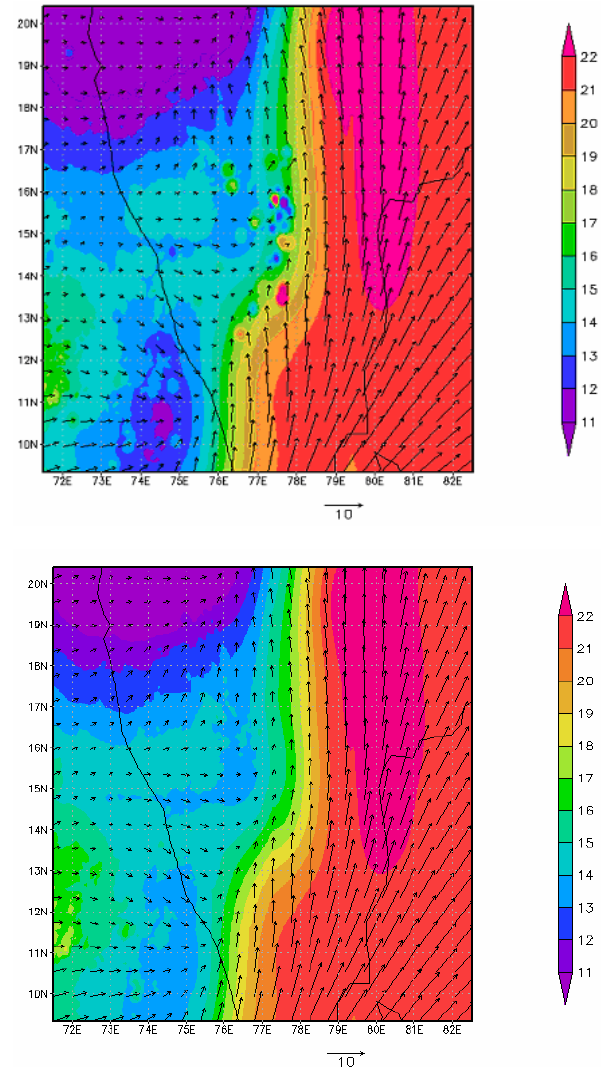
Fig. 1b. Spatial distribution of surface winds and specific humid- ity (gkg − 1 ) at 00:00UTC, 21 May 2008 without data assimilation (top) and with data assimilation